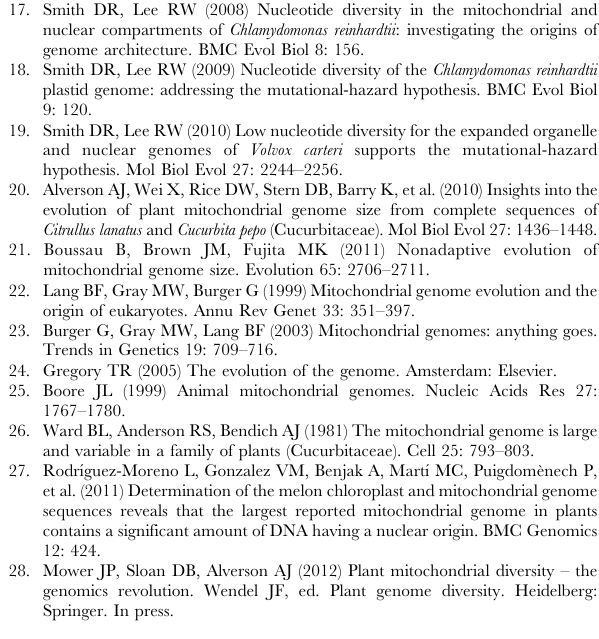
Table S2 Summary of length, GC content, gene content, and GenBank accession numbers for circular chromo- somes (and partially assembled genomic fragments in S. Table S3 Nucleotide polymorphism within Silene spe- cies. Table S4 Source of S. noctiflora and S. conica popula- tions for polymorphism analysis. Table S5 CAPS markers used to screen for maternal inheritance of mtDNA in greenhouse